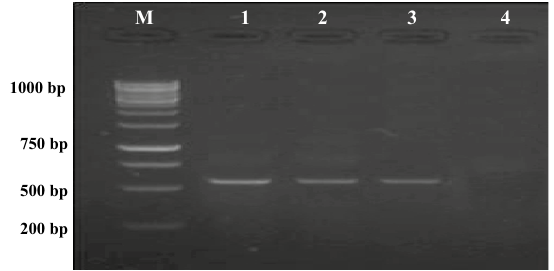
Fig. 2 PCR amplification from ITS region and amplification fragment showing approximately 594 bp. Lane M: 1 kb ladder; Lane